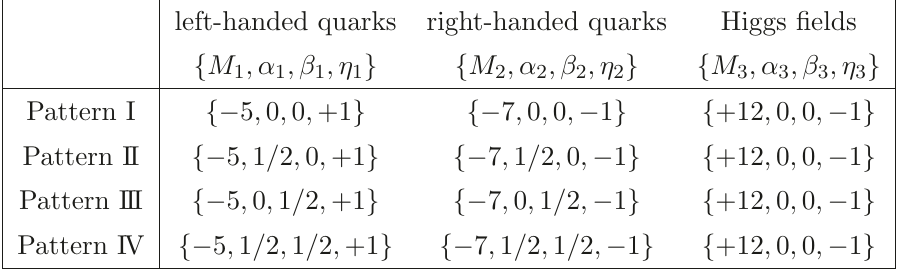
Table 2 . Sample patterns of configurations. Note that Pattern I is exactly the same as that of the previous paper